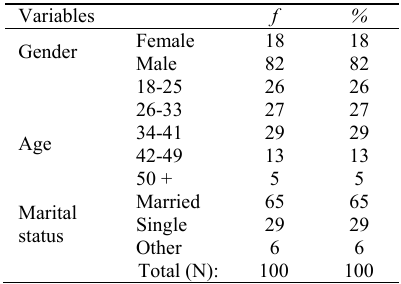
Table 1: The frequencies and percentages of the participants Variables